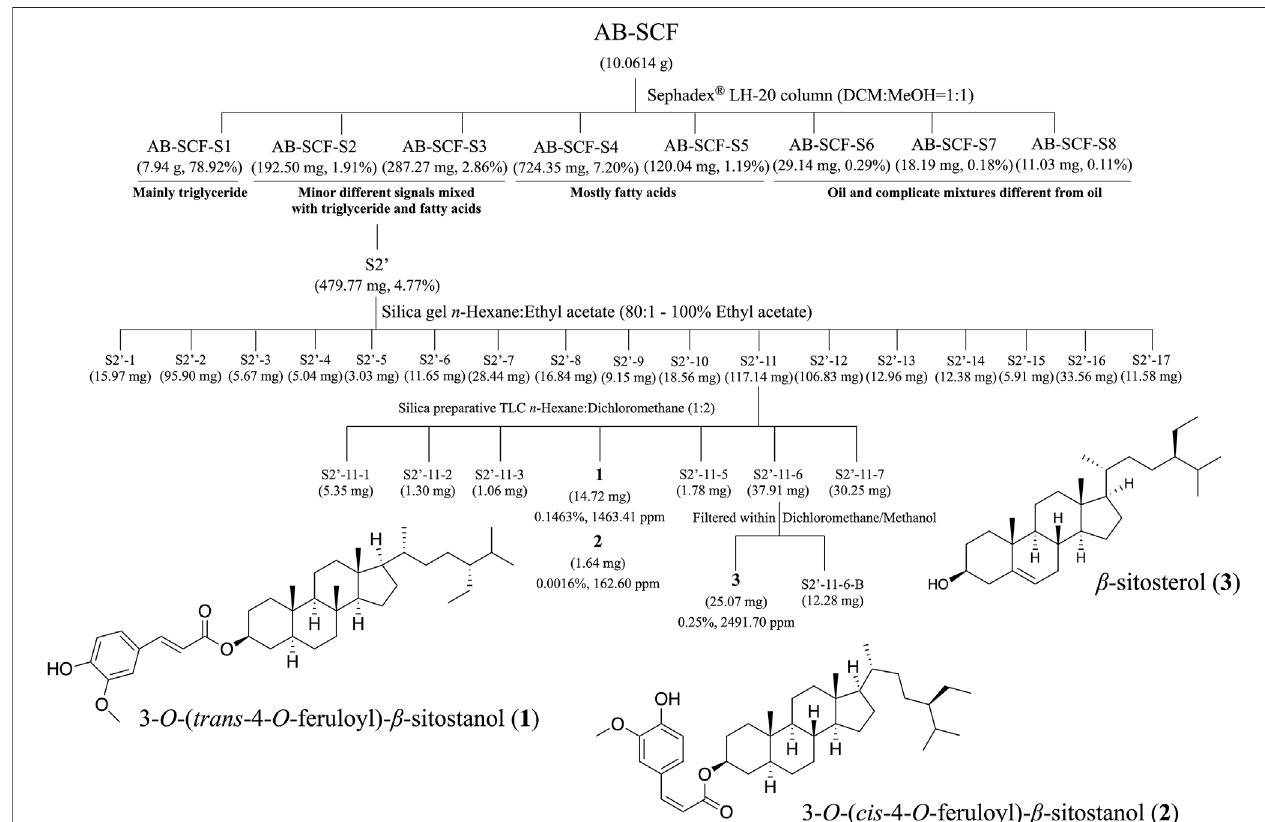
FIGURE 5 | The separationprocesses and isolatedcompounds ofnon-lipid constituentsfromAB-SCF. AB-SCFwas fi rstsize-meshed throughSephadex ® LH-20 to be pre-divided from fatty acids. AB-SCF-S2 and S3 were detected with minor signals different from lipid in 1 H NMR screens, and combined as S2 ′ for further SiO 2 column chromatographyandpreparativeTLCseparationsandpuri fi cations.Threenon-lipidpurecompounds,3- O -( trans -4-feruloyl)- β -sitostanol( 1 ),3- O -( cis -4-feruloyl)- β -sitostanol ( 2 ) and β -sitosterol ( 3 ), were obtained, and identi fi ed based on MS, 1 H NMR, 13 C NMR and comparison with authentic samples or with published data.